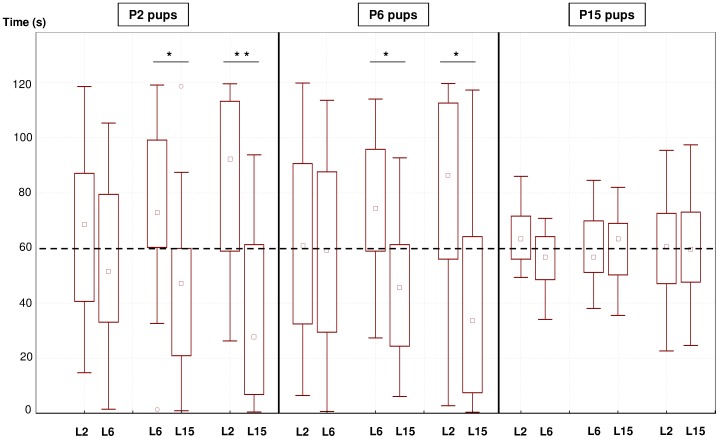
The devices used to assess differential attraction to paired odor stimuli for mouse pups aged 2, 6, and 15 days (top, middle, and bottom pictures, respectively).